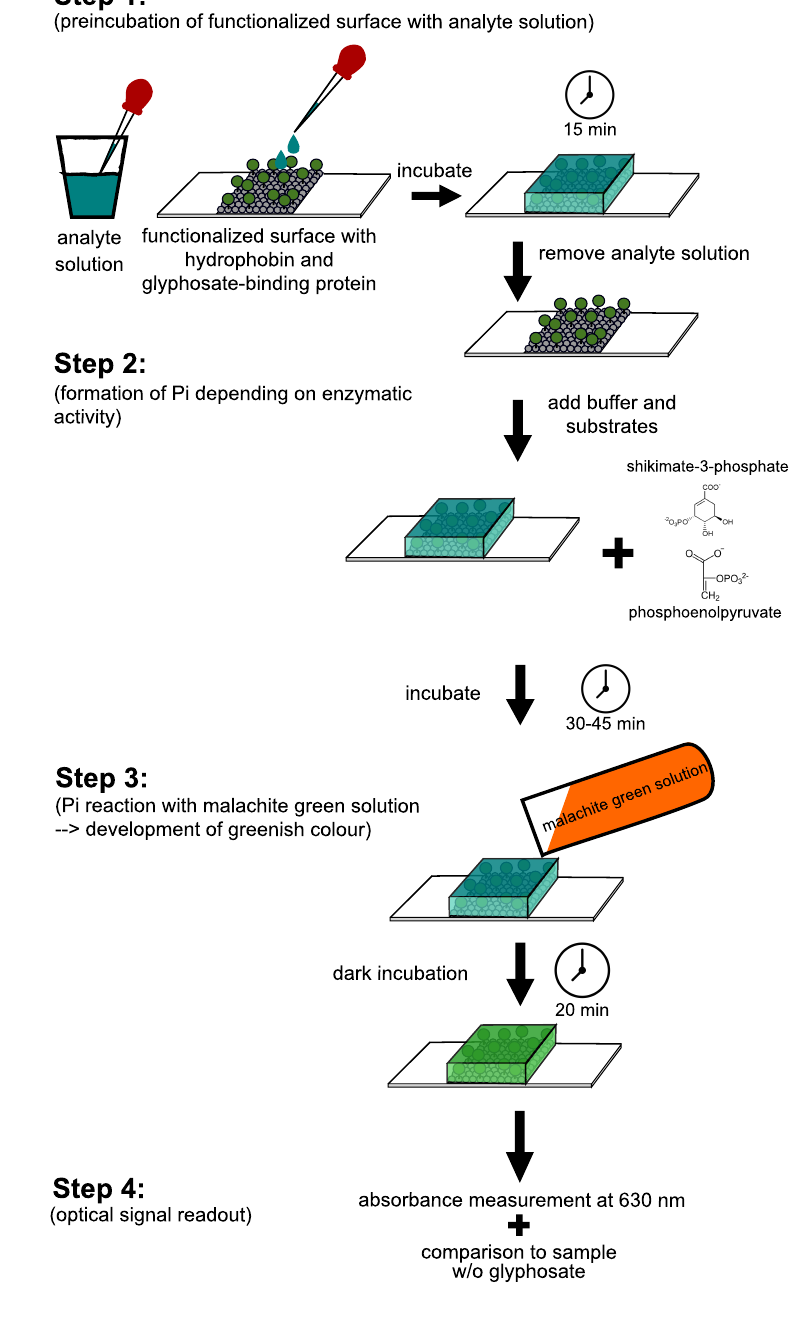
Figure 8. Workflow scheme of the glyphosate detection assay. For details see